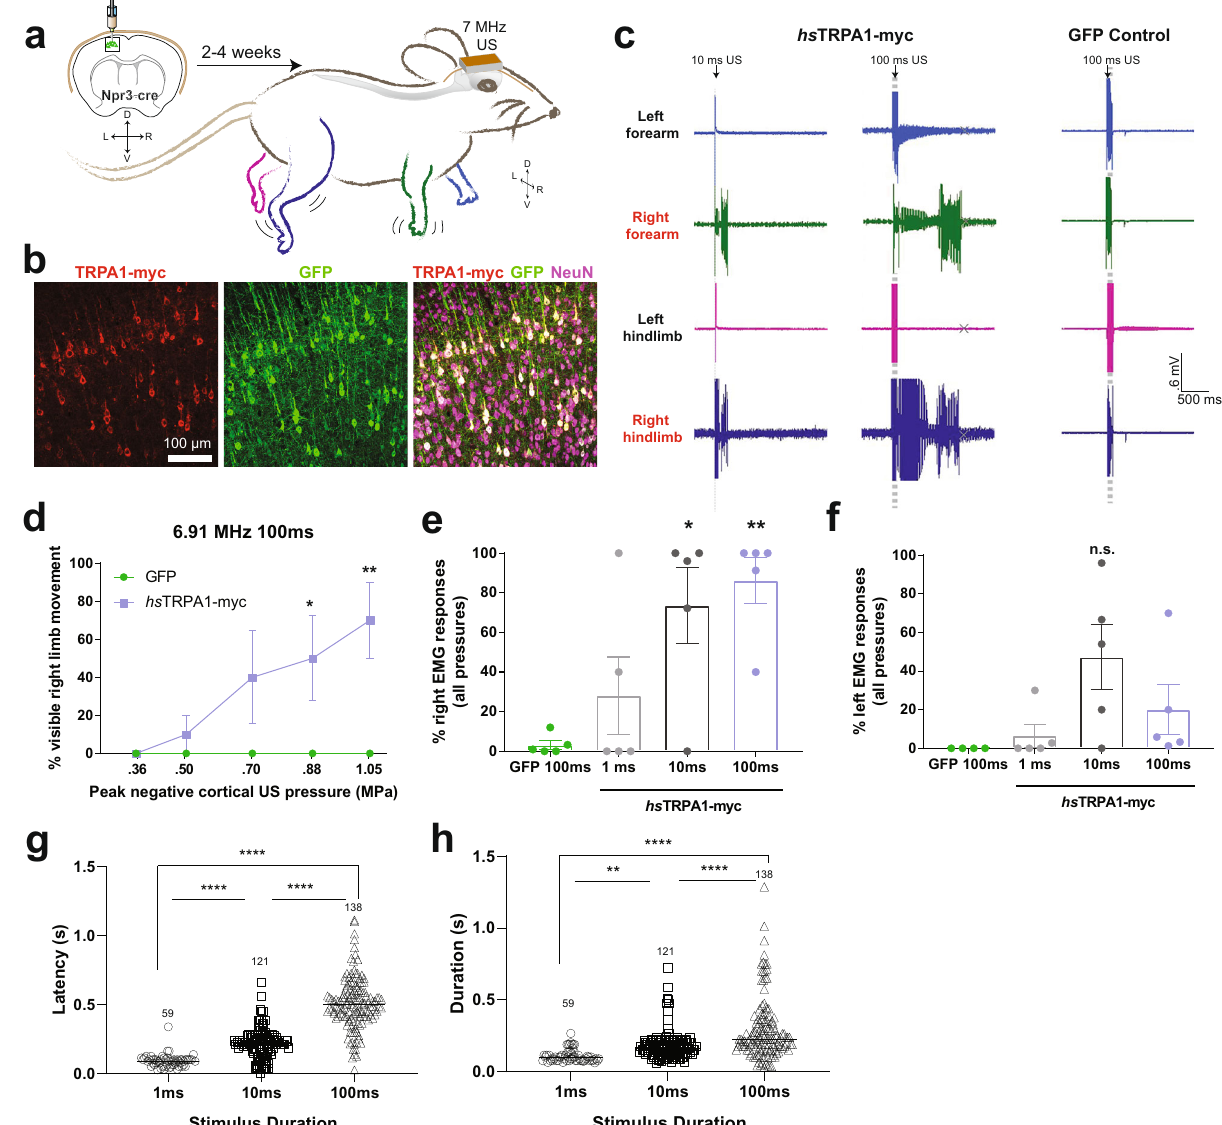
Fig. 5 hs TRPA1 enables sonogenetic activation of mouse layer V motor cortex neurons in vivo. a Schematic showing expression of hs TRPA1 or GFP controls in the left motor cortex of Npr3-Cre transgenic mice innervating the right fore and hindlimbs allowing these to be controlled with ultrasound stimuli. b Images showing expression of hsTRPA1 and GFP (co-injection marker) in layer 5 cortical neurons in vivo. Expression was evaluated in all experimental samples across multiple brai sections. c Representative EMG responses to 10 ms and 100 ms ultrasound stimuli from animals expressing hs TRPA1 and controls. d Visible right limb movements were scored in response to 100 ms ultrasound pulses of varying intensities. Plots showing percent of ( e ) right fore and hindlimb and ( f ) left fore and hindlimb EMG responses relative to number of stimulations pooled across all intensities. Plots showing ( g ) latency between the start of the ultrasound pulse and subsequent EMG response, and (h) duration from the start of the EMG response until the signal returned to baseline. d – f Data are mean + - SEM, n = 5 biologically independent animals/group, g – h , n = 59 – 138 responses collected from successful trials in n = 5 biological animals. * p < 0.05, ** p < 0.01, **** p < 0.0001 compared to GFP control by two-way ANOVA followed by Tukey ’ s multiple comparisons. Source data are provided with this